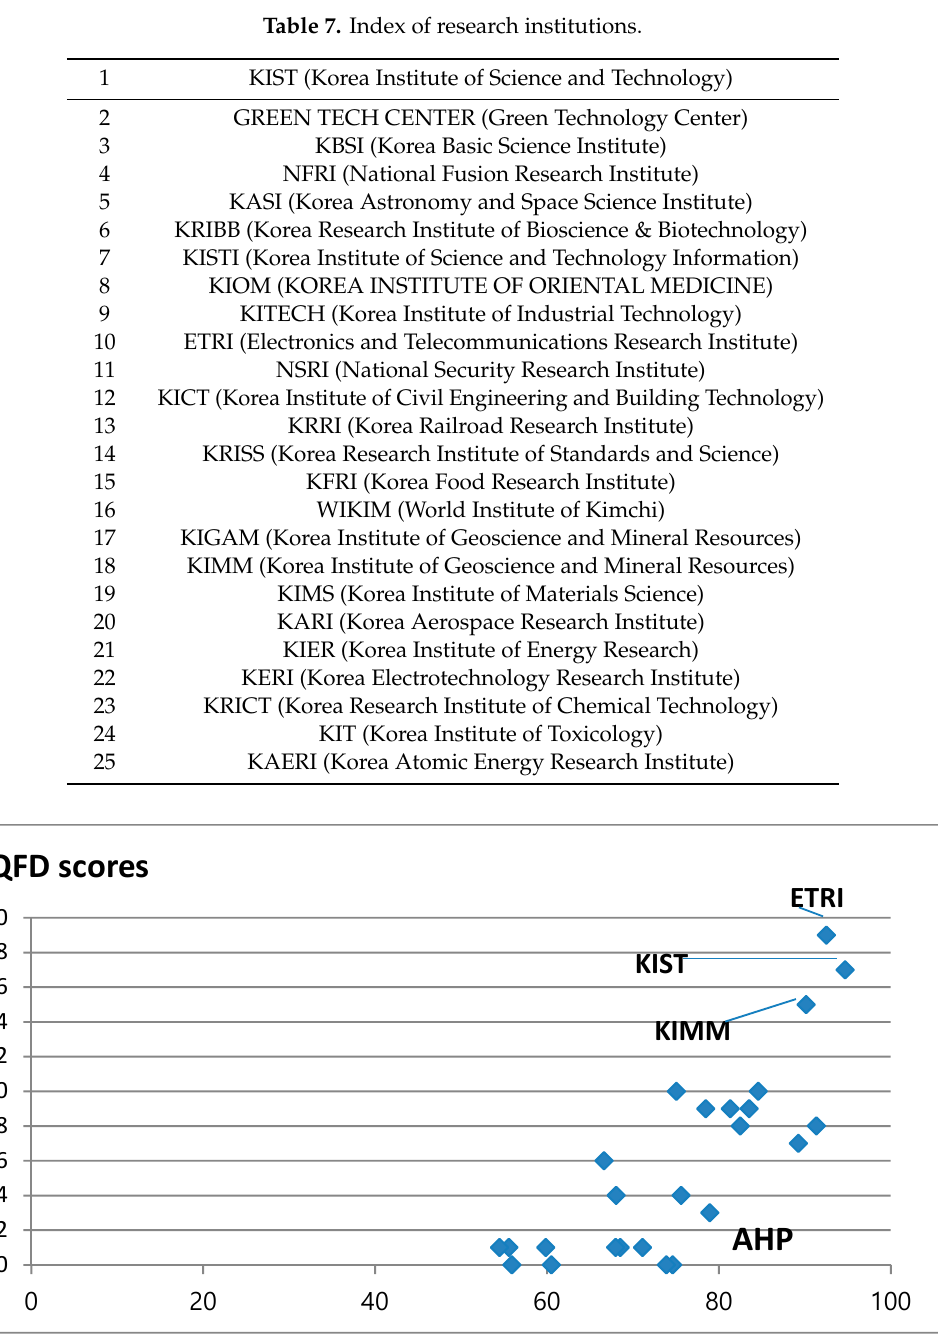
Figure 2. Fitness relationship between research institutions and the research topic of the 4th industrial revolution.